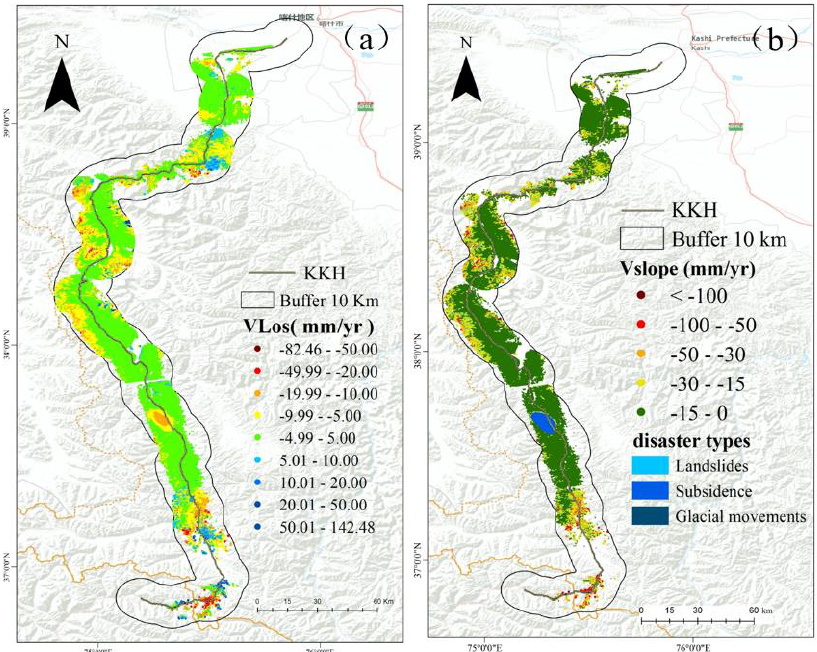
Figure 7. Ground deformation velocity map using SBAS-InSAR along the KKH. ( a ) Deformation velocity along the LOS direction. ( b ) Deformation velocity along the slope direction.